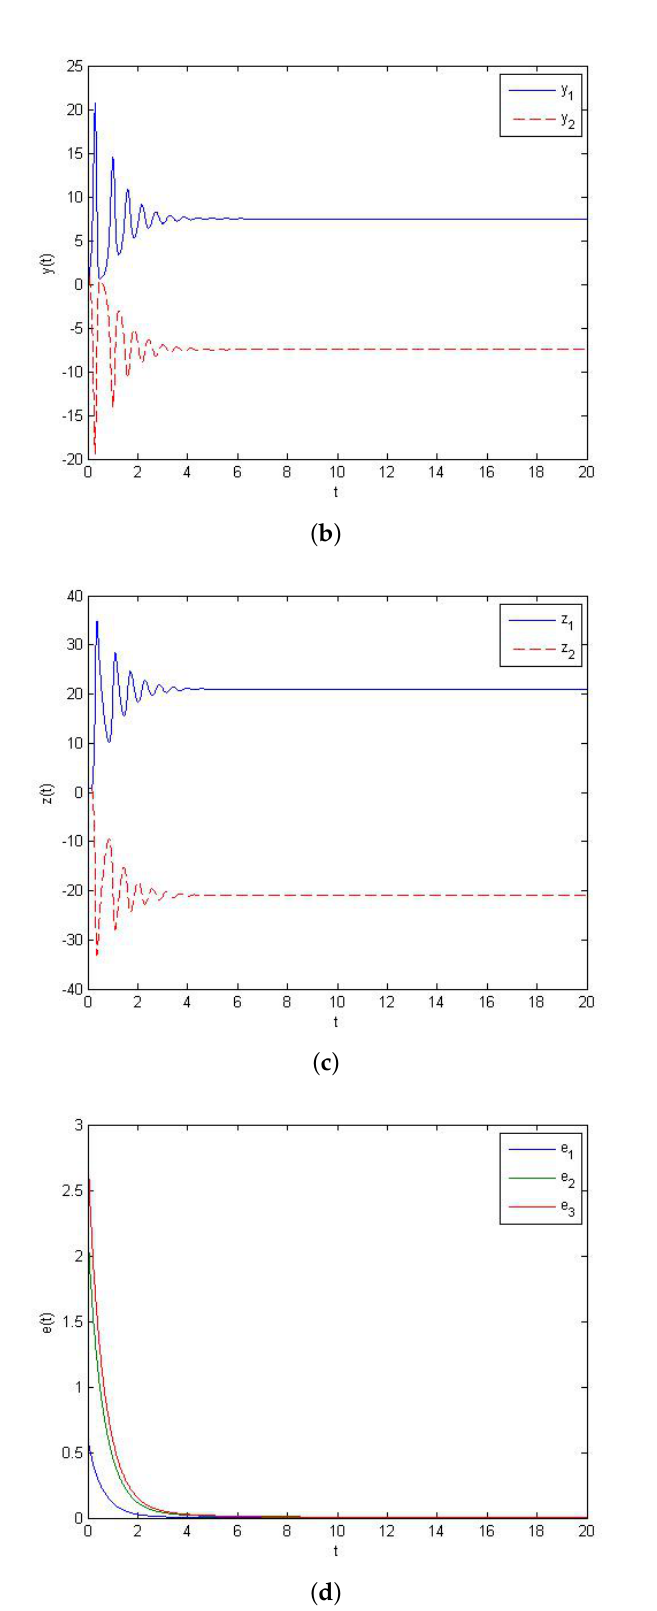
Figure 2. State trajectories of fractional-order Lorenz Systems (24) and (25) when order α = 0.96: ( a ) signals x 1 and x 2 ; ( b ) signals y 1 and y 2 ; ( c ) signals z 1 and z 2 ; ( d ) state trajectories of the error signals e 1 , e 2 , e 3